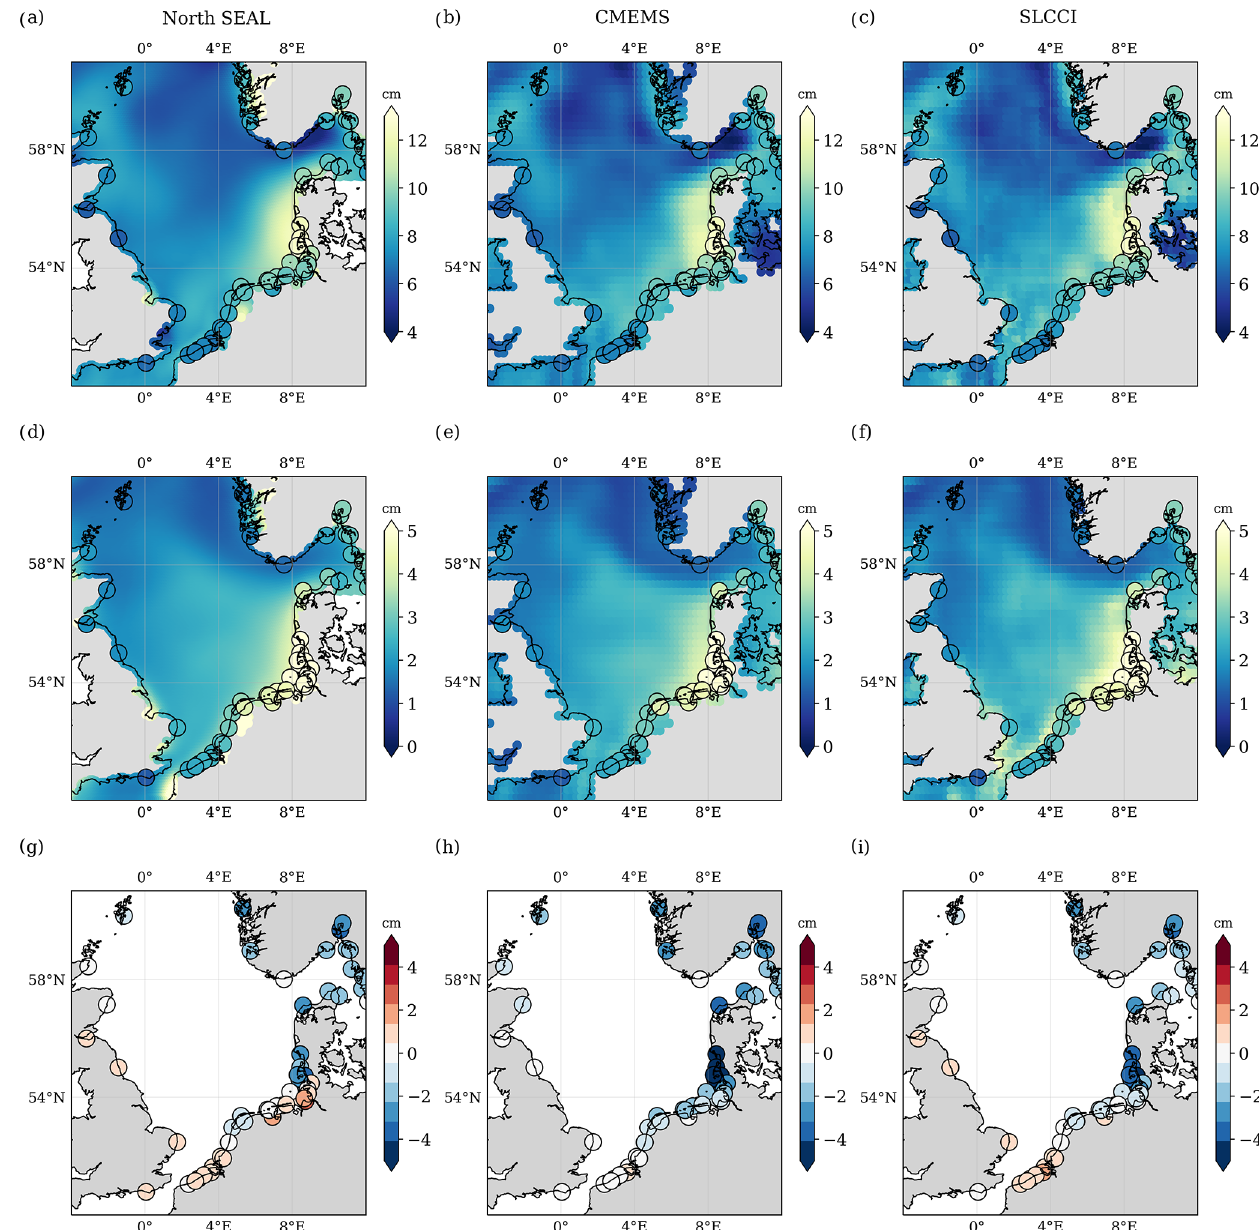
Figure 9. Amplitudes of the annual cycle (a–c) and associated uncertainties (d–f) for the three altimetry datasets and TG data. Differences of annual amplitudes at TG locations are shown in (g–i) . None of these differences are statistically